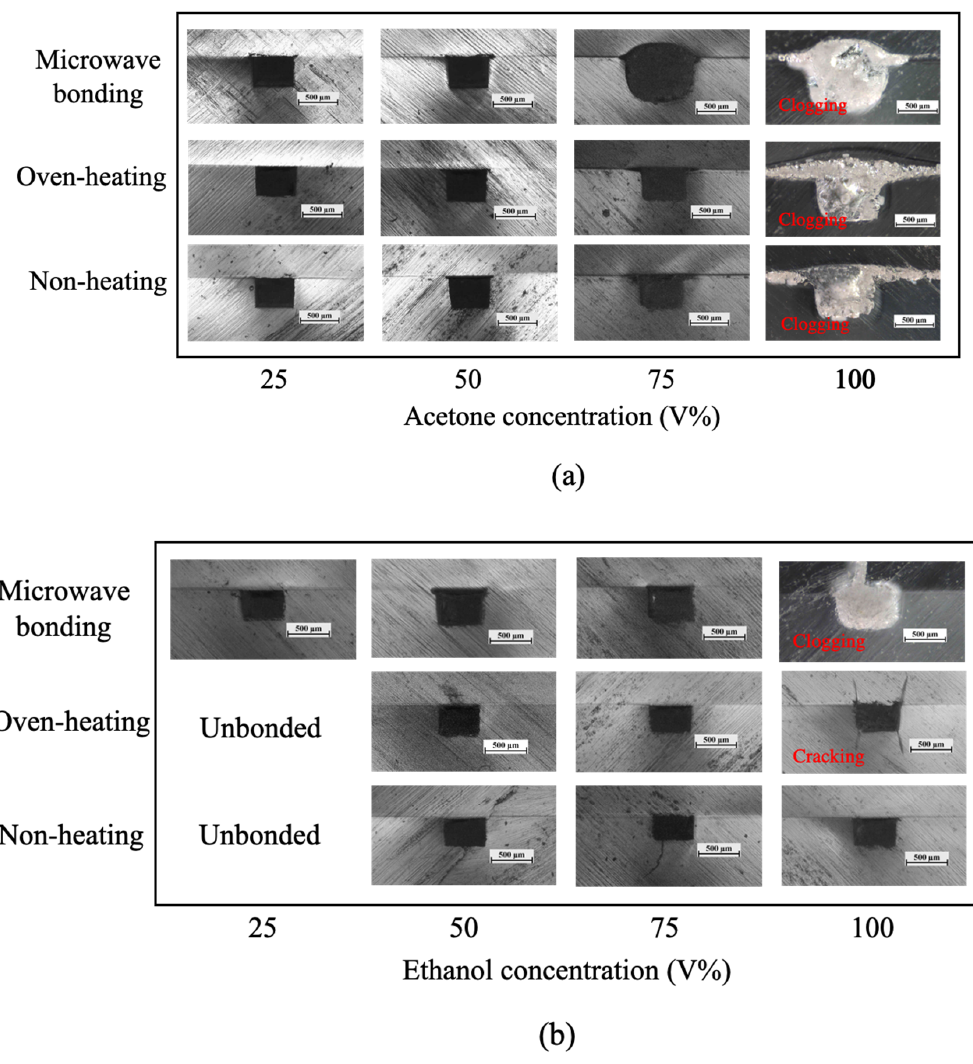
Figure 7. Cross-sectional images of PMMA microchannel with different ( a ) acetone, and ( b ) ethanol